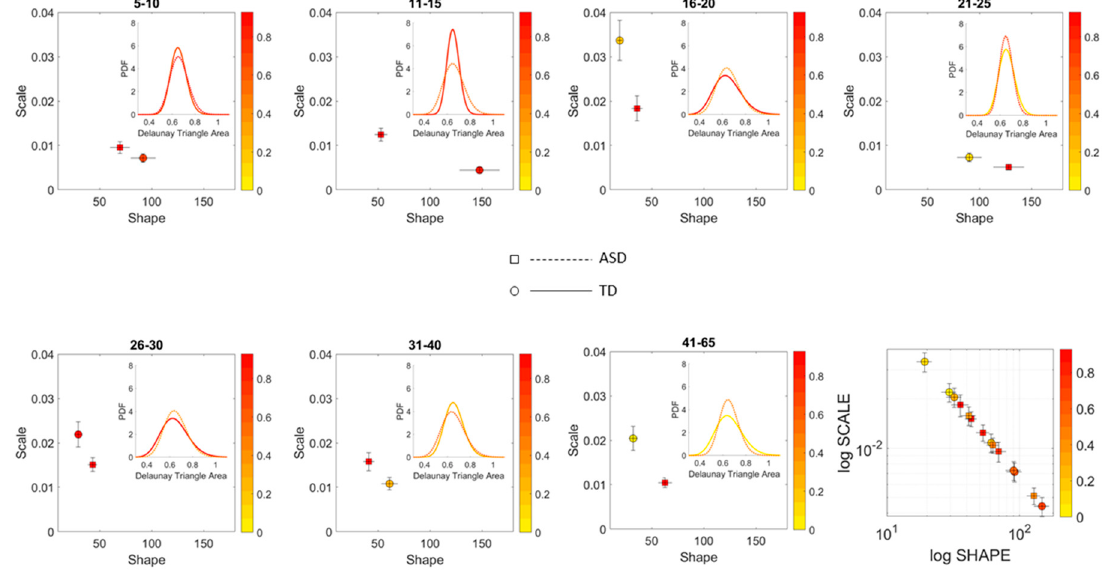
Figure 7. Characterization of the scatters’ spread using the patterns of variability of the area of the triangles making up the Delaunay triangulation in each age group. Color map represents the average EMD of the triangle area PDFs of each cluster taken as a normalized scale across the full range of values in both TD and ASD scatter spreads. Each three-dimensional scatter in Figures 5 and 6 representing the stochastic signatures of the involuntary MMS from the linear speed was characterized by a different Delaunay triangulation and the triangles’ areas spanned probability distribution capturing the variability of the scatter. Each age group spanned a statistically separable scatter when comparing normative data vs. ASD, empirically fitted by different probability distribution (dashed PDFs are from the ASD scatters). In the last right most panel, the evolution of the stochastic signatures of involuntary movements’ variability over the 5–65 years of age period can be appreciated as a trajectory on the log-log Gamma plane parameter space.